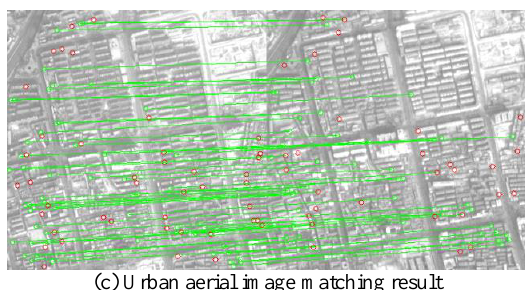
(c) Urban aerial image matching result Figure 5 Typical poor textural image matching with EW- HOGM (the circles represent the